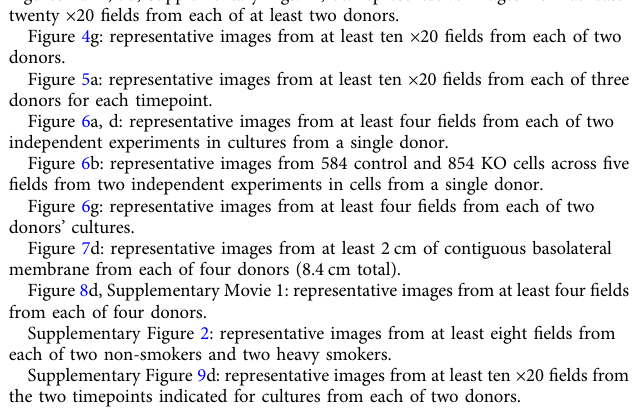
Figure 6a, d: representative images from at least four fi elds from each of two independent experiments in cultures from a single donor. Figure 6b: representative images from 584 control and 854 KO cells across fi ve fi elds from two independent experiments in cells from a single donor. Figure 6g: representative images from at least four fi elds from each of two donors ’ cultures. Figure 7d: representative images from at least 2 cm of contiguous basolateral membrane from each of four donors (8.4 cm total). Figure 8d, Supplementary Movie 1: representative images from at least four fi elds from each of four donors. Supplementary Figure 2: representative images from at least eight fi elds from each of two non-smokers and two heavy smokers. Supplementary Figure 9d: representative images from at least ten ×20 fi elds from the two timepoints indicated for cultures from each of two